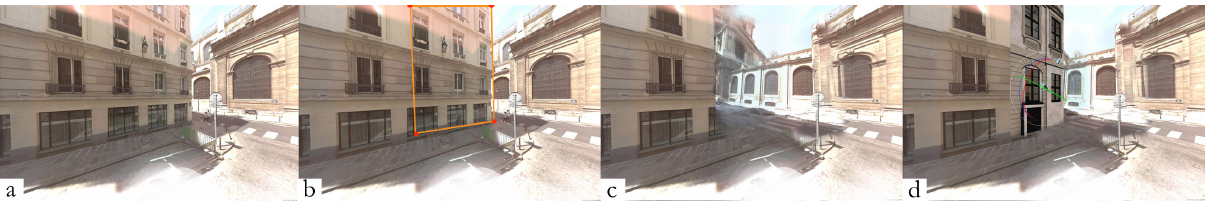
Figure 2. Use case design: (a) Original view in situ, (b) The user selects a part or an entire building to remove, (c) After removal, the real building is no more visible, (d) The user adds a part of a 3D Building